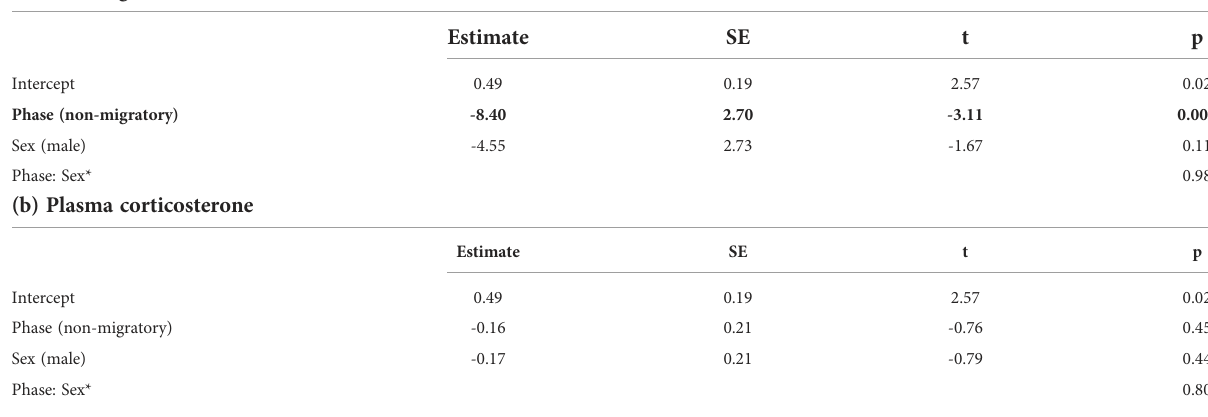
TABLE 1 Results of GLMs assessing the effects of sampling phase and sex on plasma concentrations of (a) ghrelin or (b)